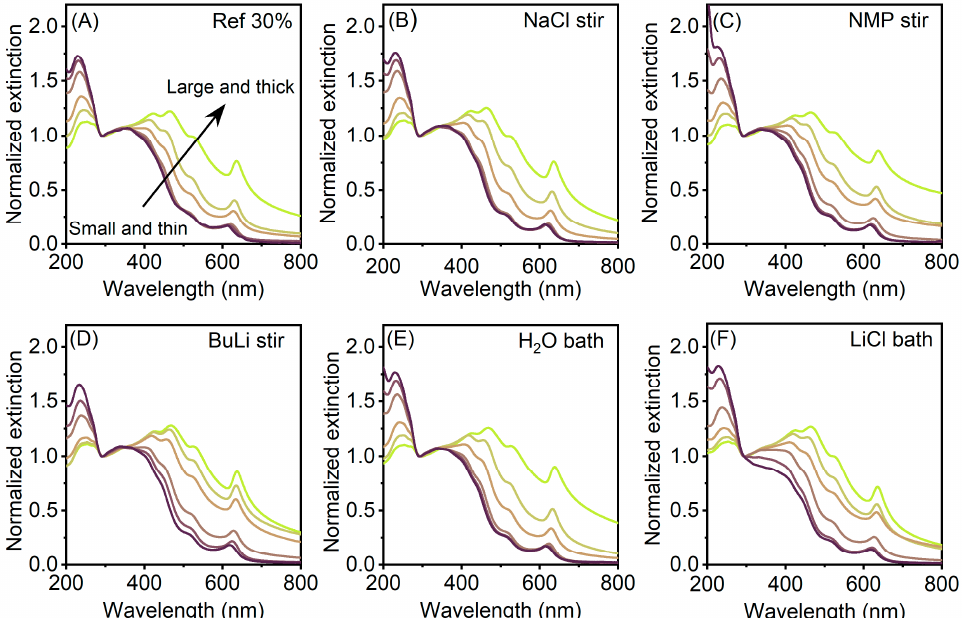
Figure A1. Optical extinction spectra of liquid ‐ phase exfoliated and size selected WS 2 nanosheet dispersions. The bulk WS 2 powder was subjected to the following pretreatments, prior to exfolia ‐ tion: ( A ) Reference, ( B ) stirring in H 2 O/NaCl, ( C ) stirring in NMP, ( D ) stirring in hexane/ n ‐ BuLi, ( E ) bath sonication in H 2 O, ( F ) bath sonication in an H 2 O/LiCl. The exfoliation was executed by tip sonication with an 30% amplitude. Size dependent spectral changes are indicated by the arrow in ( A ).